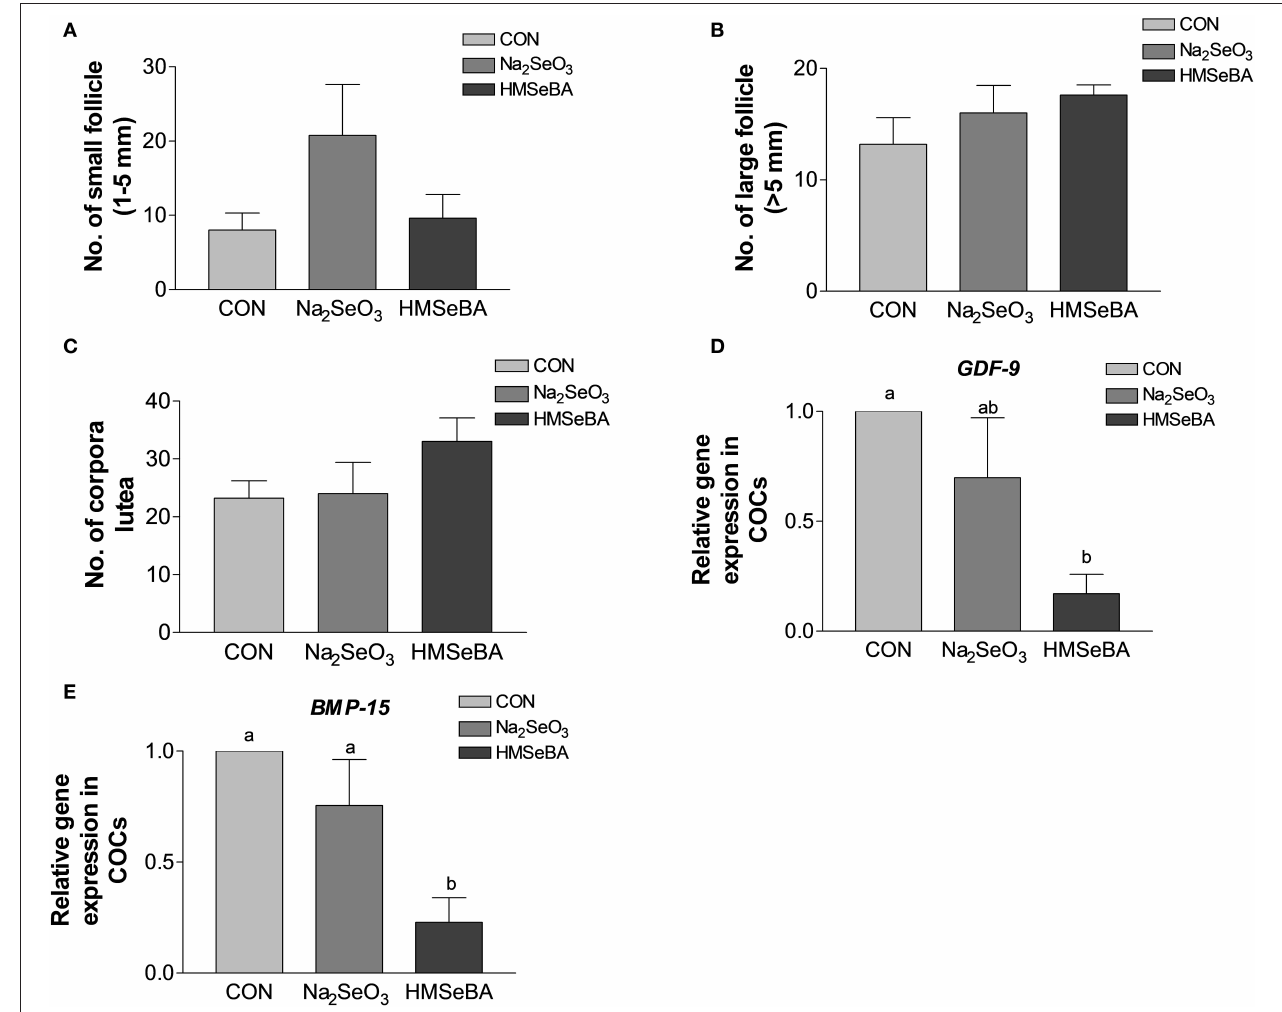
FIGURE 3 | Effects of dietary selenium supplementation on the development of follicles and relative gene expression of COCs in gilts. (A) Number of small follicle (diameter 1–5mm). (B) Number of large follicle (diameter > 5mm). (C) Number of corpora lutea (represented the number of ovulations of last estrus). (D) Relative gene expression of GDF-9 in cumulus-oocyte complexes (COCs). (E) Relative gene expression of BMP15 in COCs. Mean values with different superscript letters were significantly different ( P < 0.05). CON, basal diet; Na 2 SeO 3 , 0.3mg Se/kg Na 2 SeO 3 ; HMSeBA, 0.3mg Se/kg HMSeBA; GDF-9 , growth differentiation factor-9; BMP-15 , bone morpho-genetic